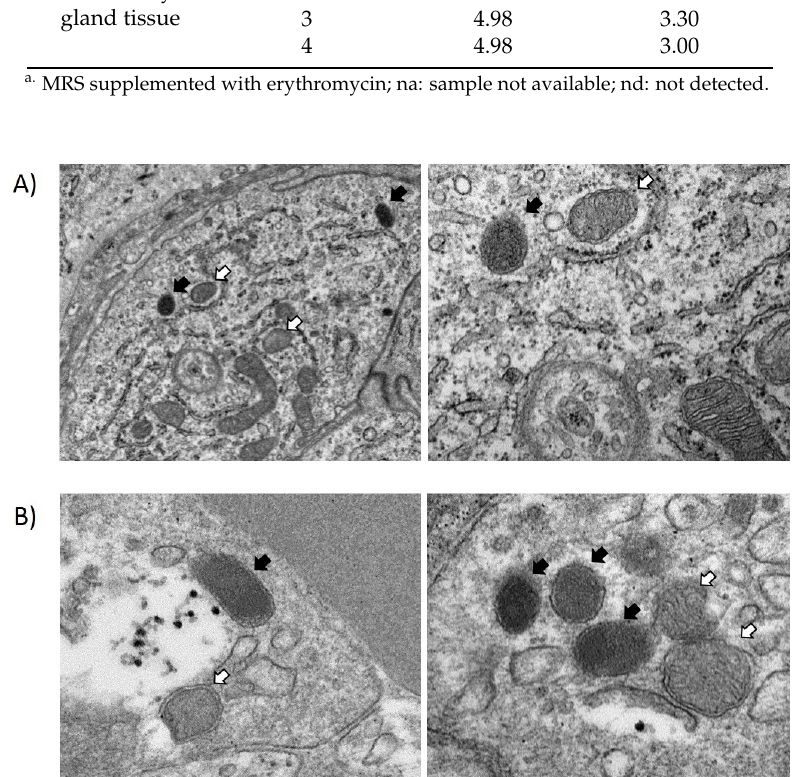
Table 2. L. salivarius PS2 counts (log 10 cfu/g) in the biological samples collected from mice (1 and 2: non ‐ pregnant mice; 3 and 4: pregnant mice) that were fed with L. salivarius PS2 cells transformed with plasmid pMG36e:: luxAB.